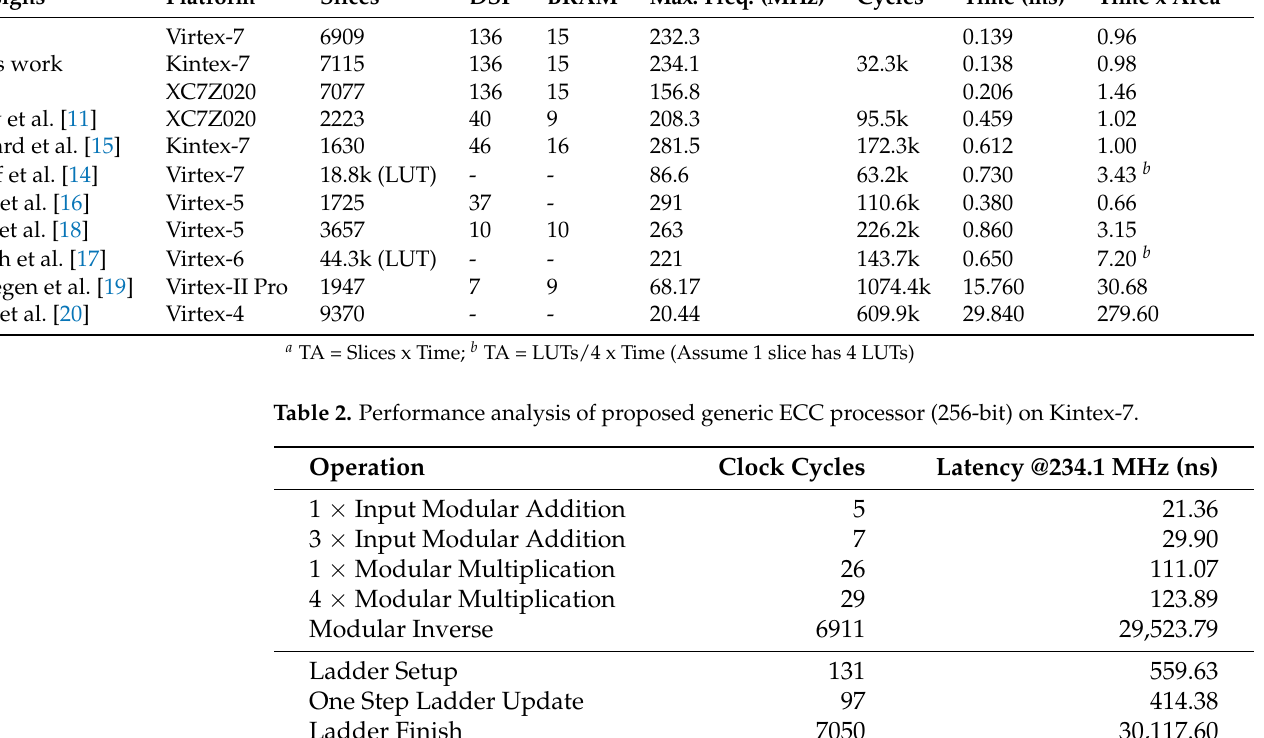
Table 1. Performance comparison of the proposed generic ECC processor for Weierstrass curve up to 256-bit modulus size. Designs